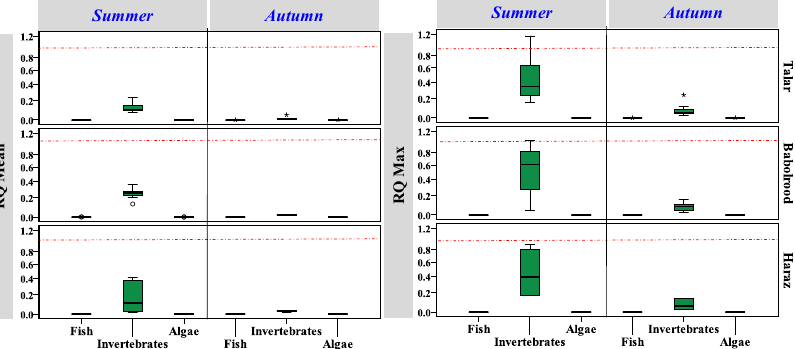
Figure 3. Estimated Risk Quotient (RQ) for different trophic levels in Talar Babolrod and Haraz rivers in Iran. * A high calculated risk number in a sampling.